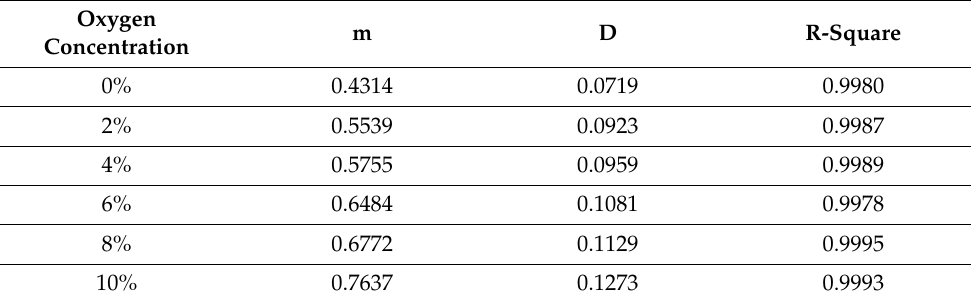
Table 2. Diffusion Coefficients of Water Molecules. Oxygen Concentration